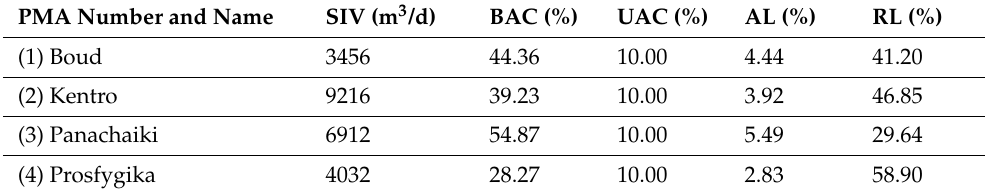
Table 2. Allocation of the system input volume (SIV) into BAC (billed authorized consumption), UAC (unbilled authorized consumption), AL (apparent losses), and RL (real losses) for the four largest pressure management areas (PMAs) of the city of Patras, for the eight-month long high consumption period from 1 March 2019 to 31 October 2019. Numbers indicate the locations of PMAs in Figure